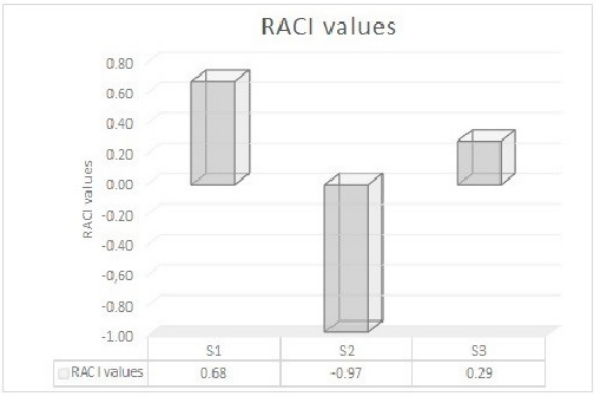
Figure 4. Relative Antioxidant Capacity Index (RACI) values of S. officinalis essential oils (S1–S3).